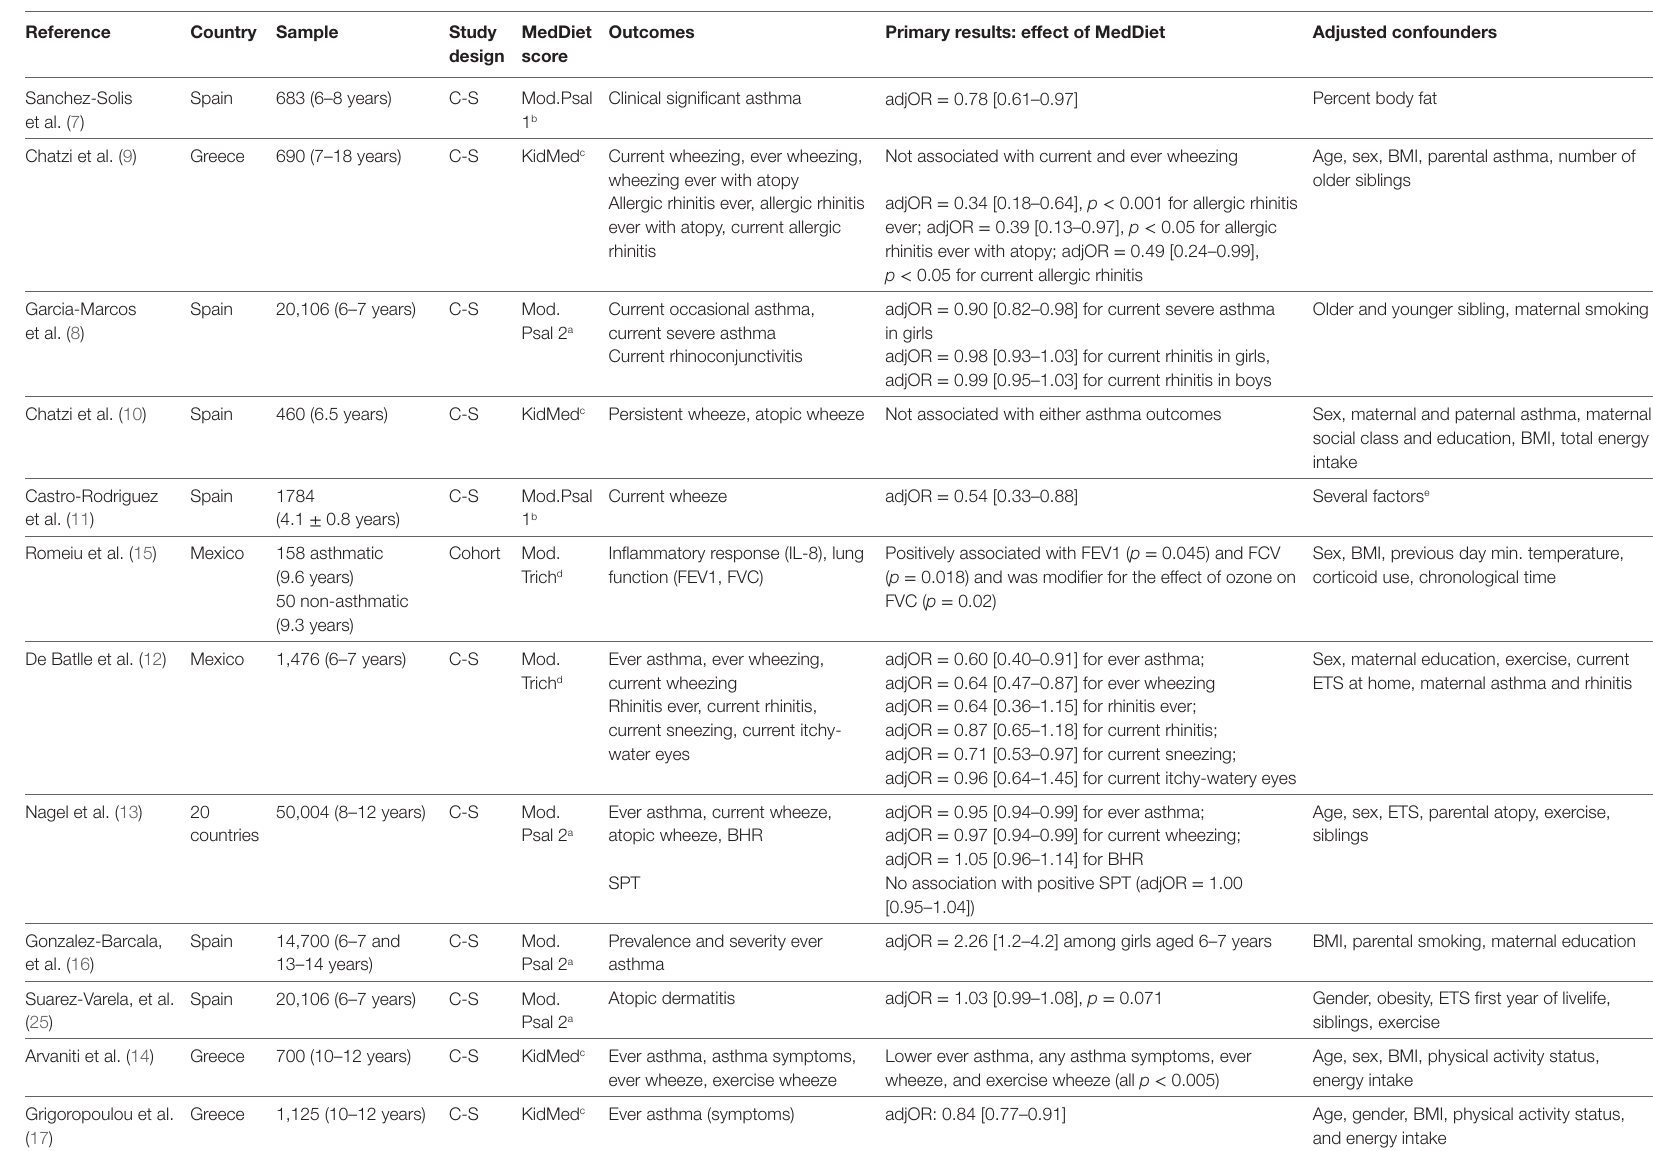
TAble 1 | Summary of studies reporting the association between adherence to MedDiet and asthma/wheezing, allergic rhinitis, and dermatitis/eczema in